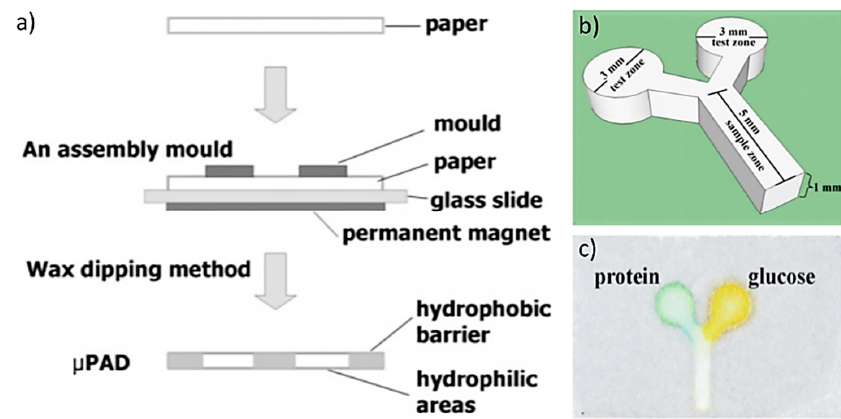
Figure 5. Wax dipping method and detection of analytes: ( a ) Procedure for patterning paper by wax dipping ( left ). ( b ) Shape and size of an iron mask. ( c ) Detection of protein and glucose on a paper microfluidic device by the wax dipping method (Adapted with the permission from Elsevier) [29].